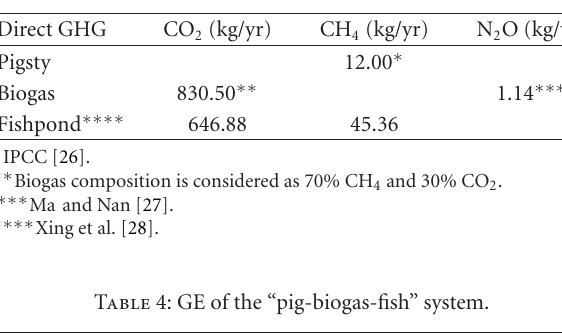
Table 3: Direct GHG emissions of the “pig-biogas-fish” system.